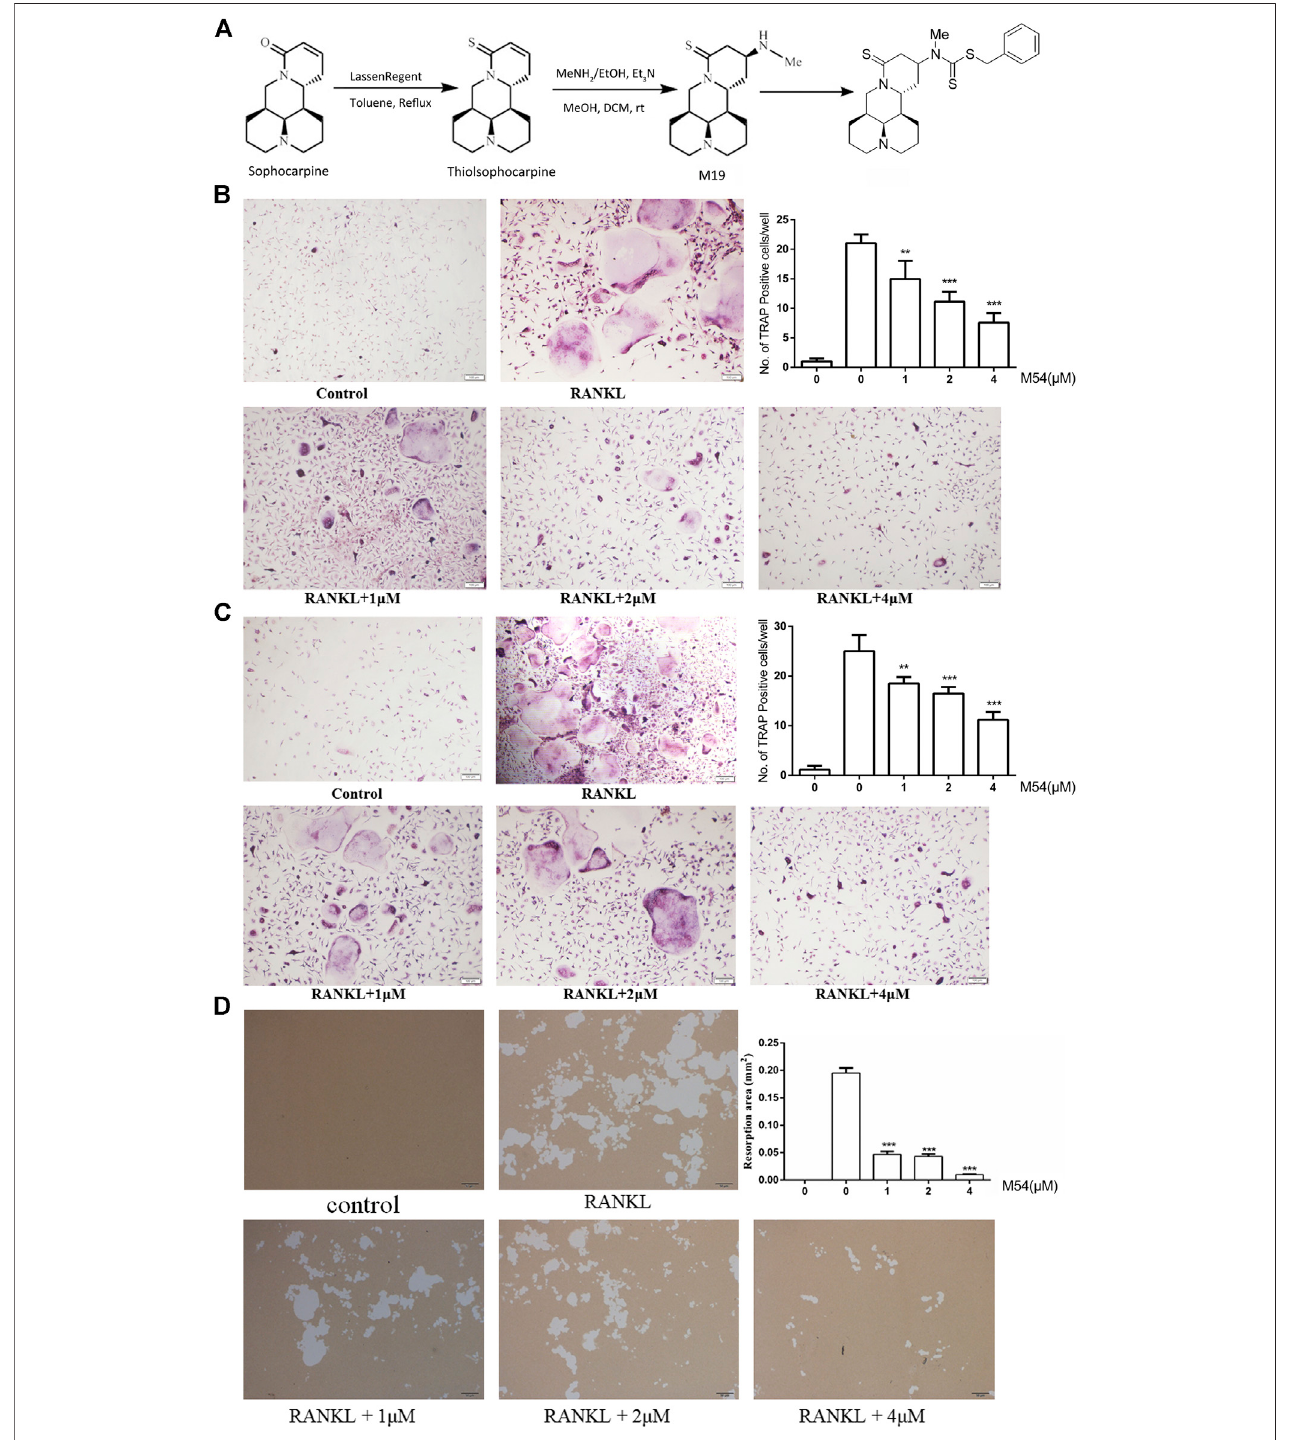
FIGURE 1 | M54 inhibits RANKL-induced osteoclast differentiation and bone resorption in vitro. (A) Chemical structure of M54 and the synthesis process. (B) Formation of TRAP-positive cells from BMMCs and the quanti fi cation of formed osteoclasts. (C) Formation of TRAP-positive cells from RAW264.7 cells and the quanti fi cation of formed osteoclasts. (D) The resorption area on the bone biomimetic synthetic surface was quanti fi ed by image analysis ( p p < 0.05, pp p < 0.01, ppp p < 0.001).